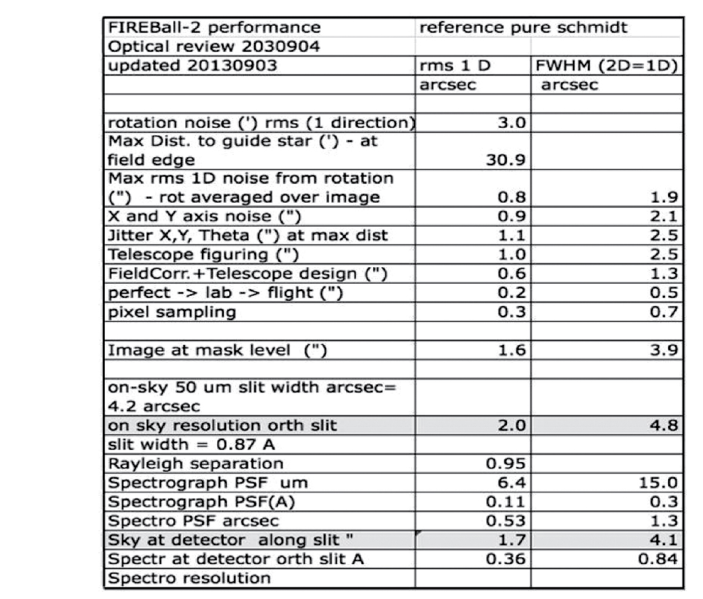
Figure 10: Spectral and spatial optical